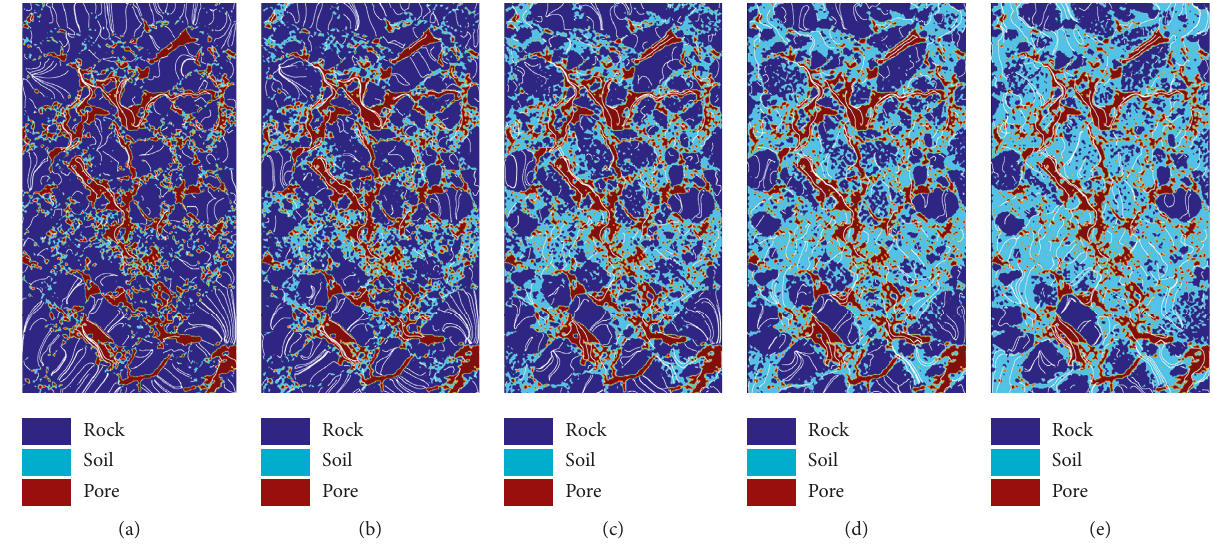
Figure 12: Seepage simulation results of A-6 to A-10 samples.